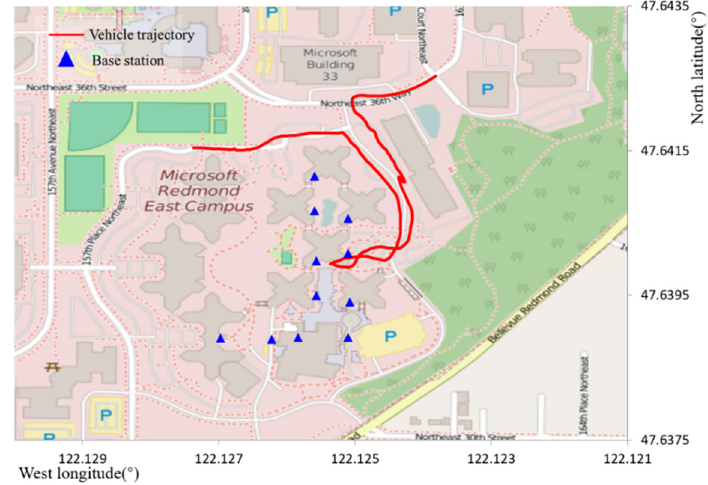
Figure 3. Vehicle trajectory. The sorted data fields are presented in Table 5. Table 5. Integration of data